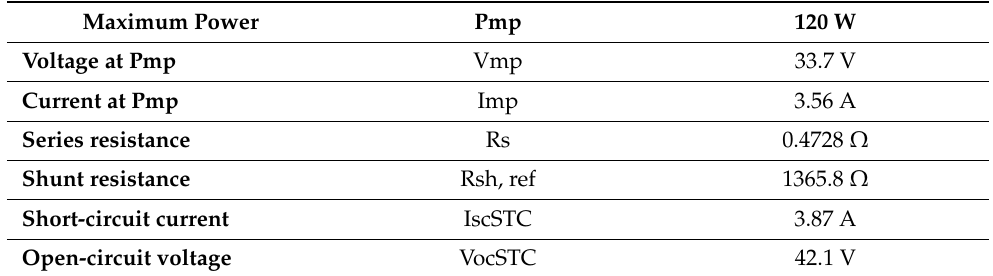
Table 1. Parameters of the BP MSX-120 panel.